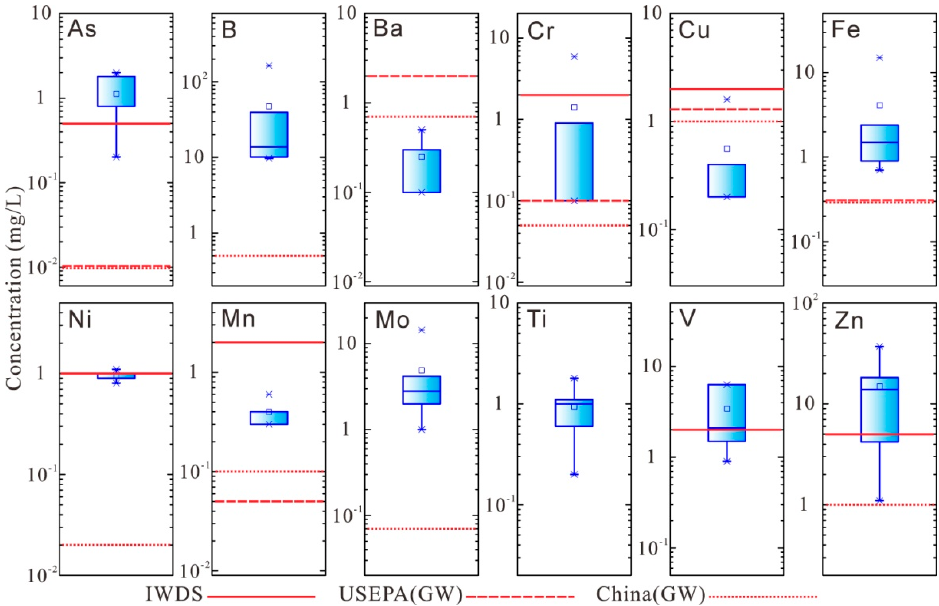
Figure 4. Boxplot of the concentration of minor elements in red mud leachate (Red lines indicates the MCLs of groundwater quality standards).